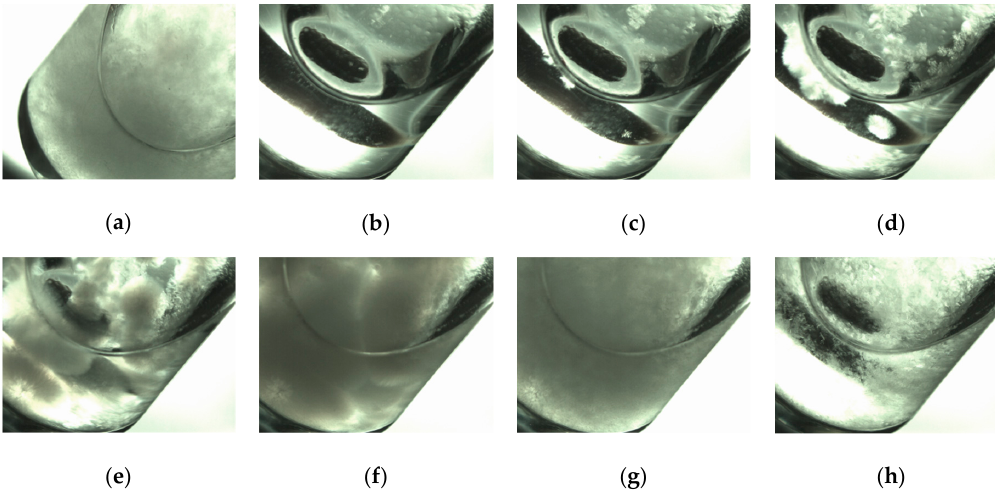
Figure 2. Macroscopic evolution of the solution of (R) -9-HSA in acetonitrile (0.5% w / w ): frames taken at successive times. In ( b )–( e ) and ( h ) a small stirring bar is detectable at the bottom of the 10-mL test tube.